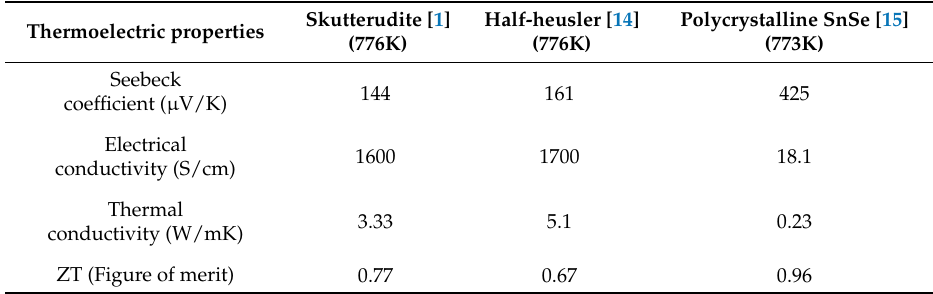
Table 1. Thermoelectric property comparison between well-known thermoelectric materials which are utilized in an intermediate temperature range.